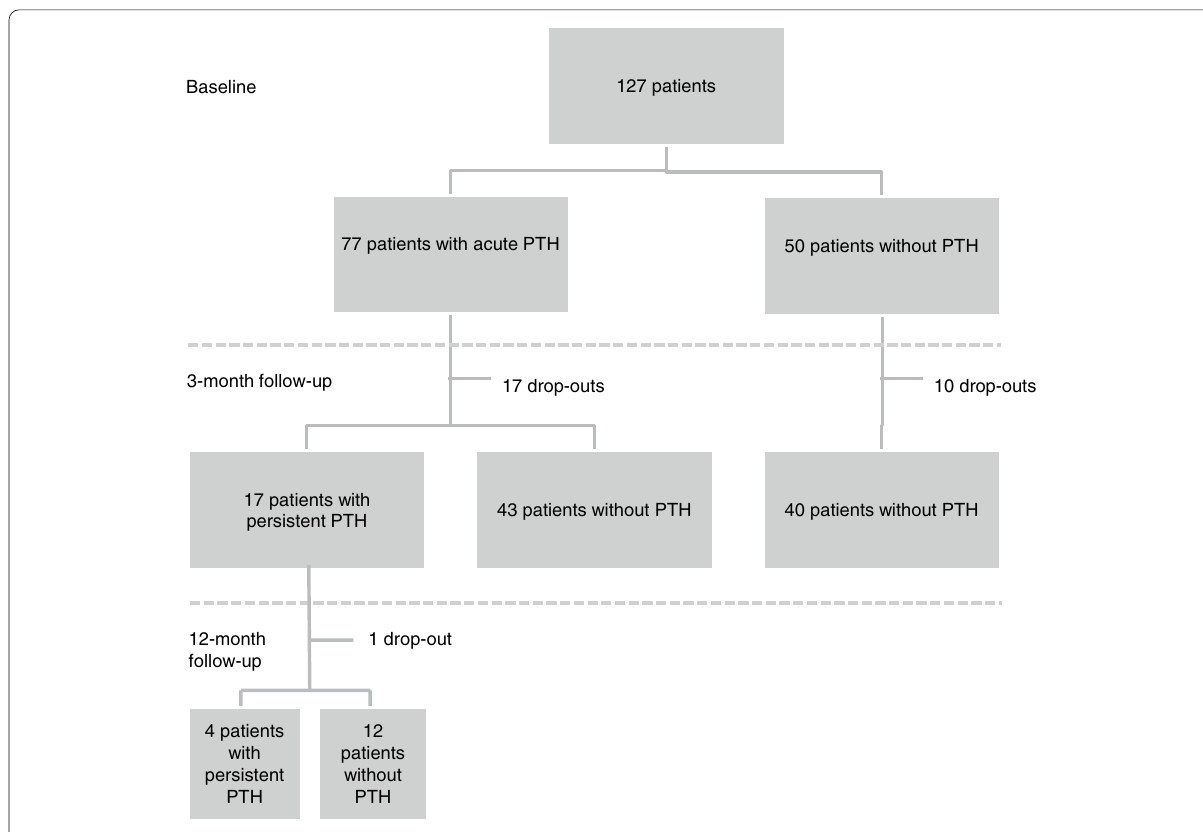
Fig. 1 Distribution of patients according to presence of post-traumatic head-ache